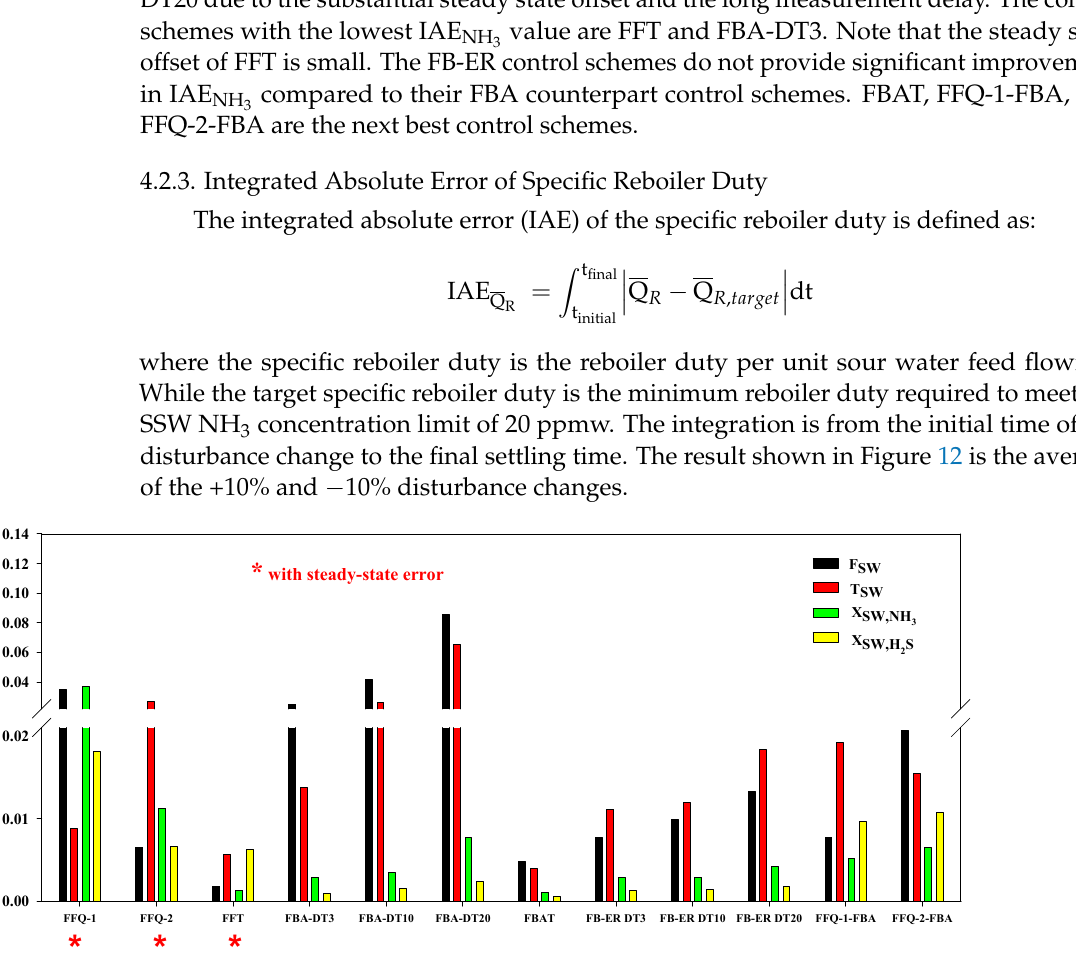
Figure 12. IAE of specific reboiler duty results of all control schemes for the sour water feed stream disturbances, including flowrate, temperature, NH 3 concentration, and H 2 S concentration. (* with steady state offset).